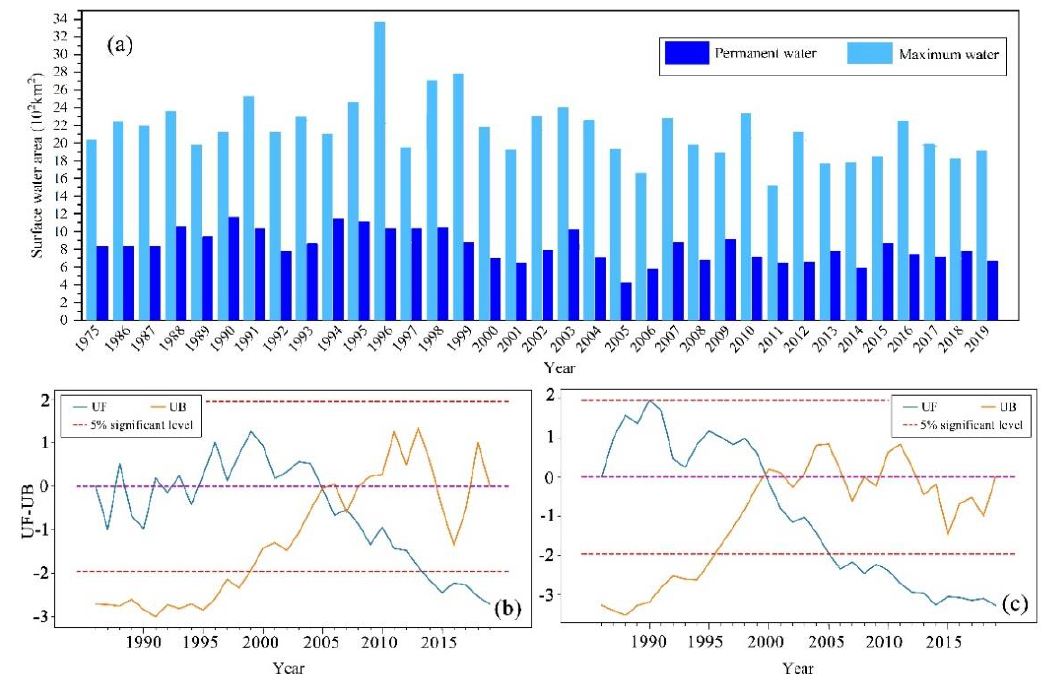
Figure 5. Changes of surface water from 1975 to 2019 at Dongting Lake: ( a ) Permanent and maximum surface water histograms; ( b ) M-K test results of maximum surface water; and ( c ) M-K test result of permanent occurrent water.